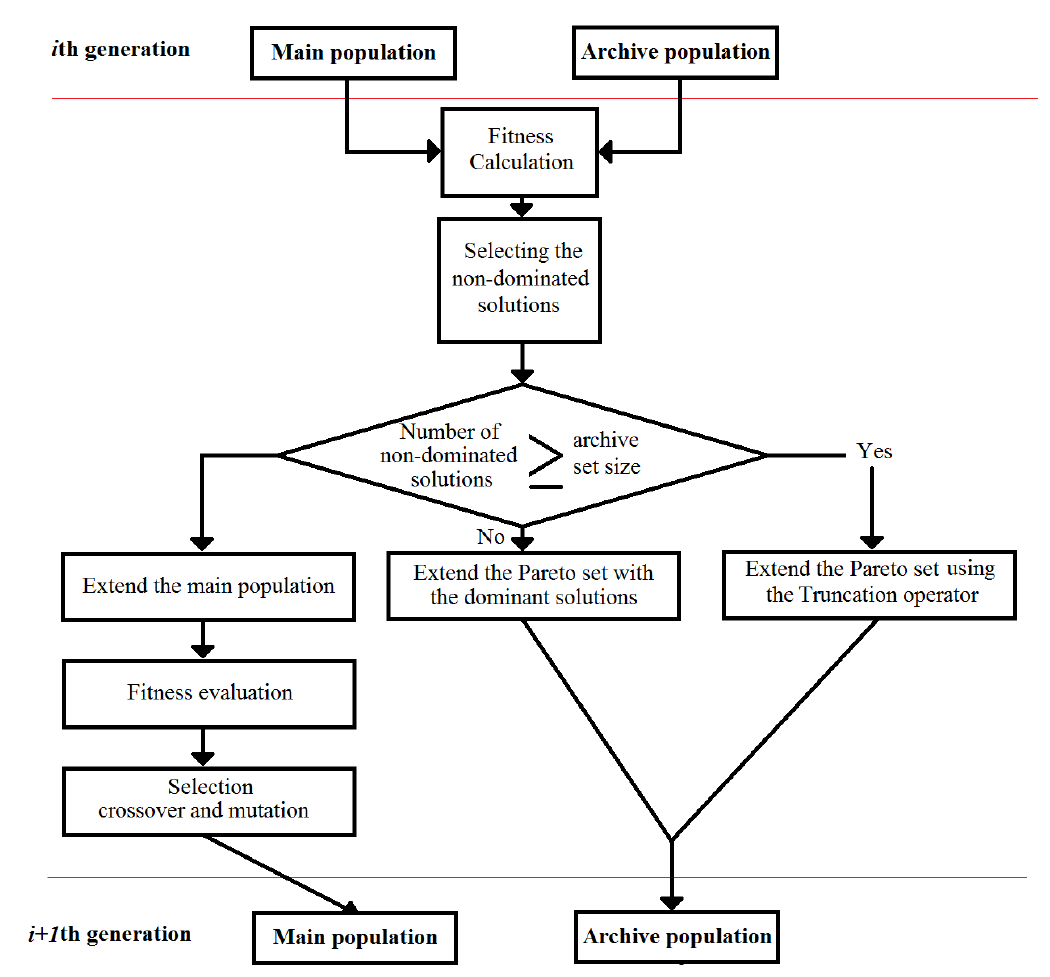
Figure 3. Strength Pareto evolutionary algorithm II (SPEA II) algorithm